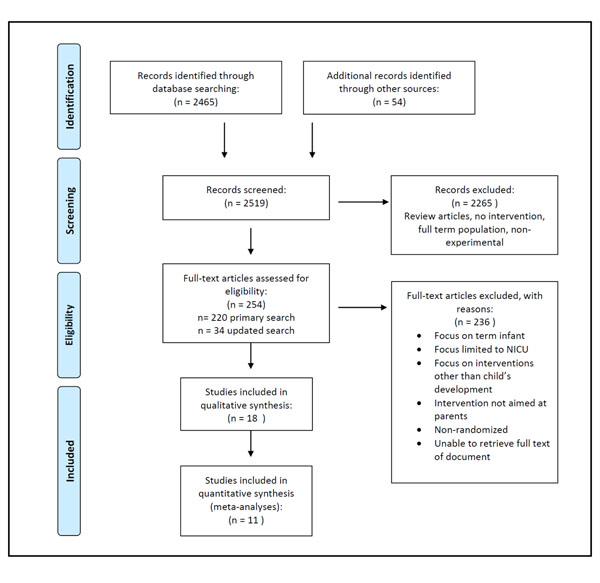
Study selection flow diagram